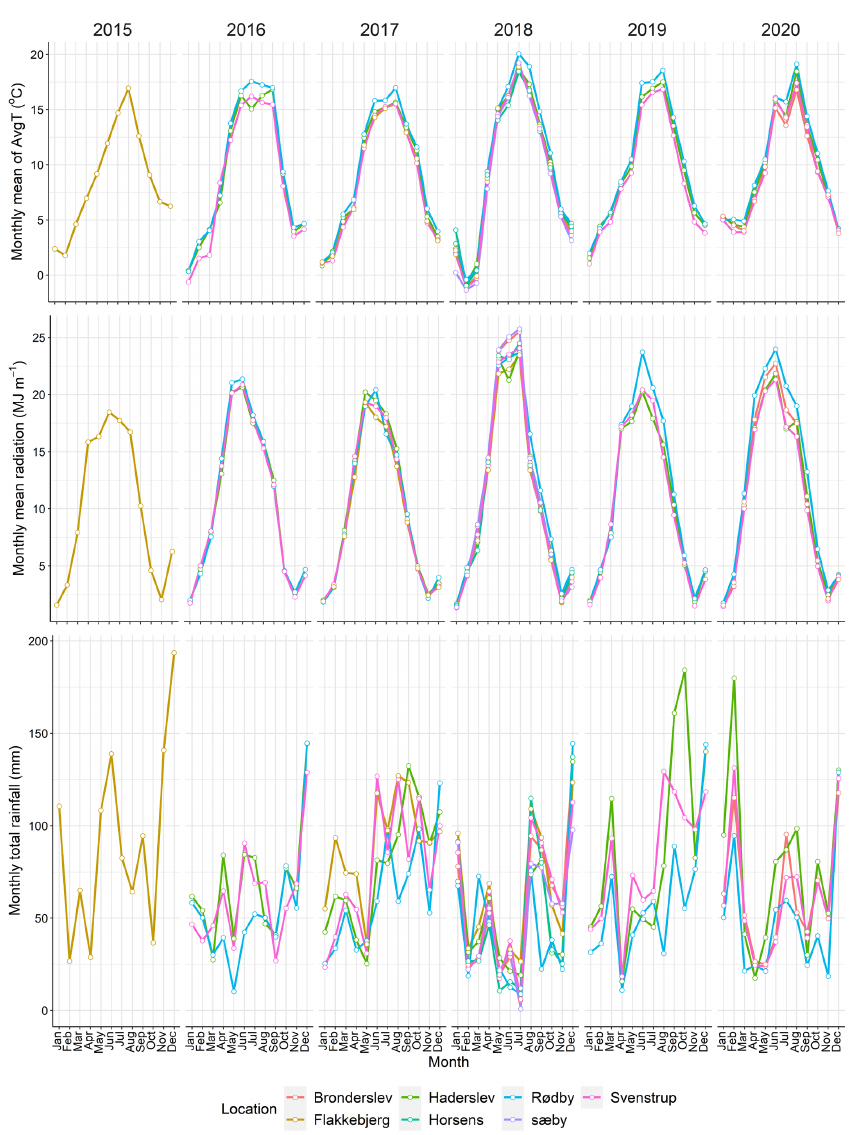
Figure 8. Monthly mean of average temperature (AvgT), radiation, and rainfall of calibration and evaluation locations for the experimental years at each location from 2015 to 2020 are presented in the upper panel, middle, and lower panel, respectively.